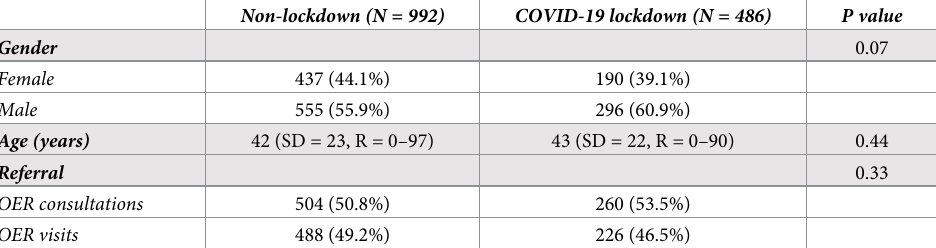
Table 1. Demographics variables of ophthalmologic emergency department encounters in non-lockdown and COVID-19 lockdown